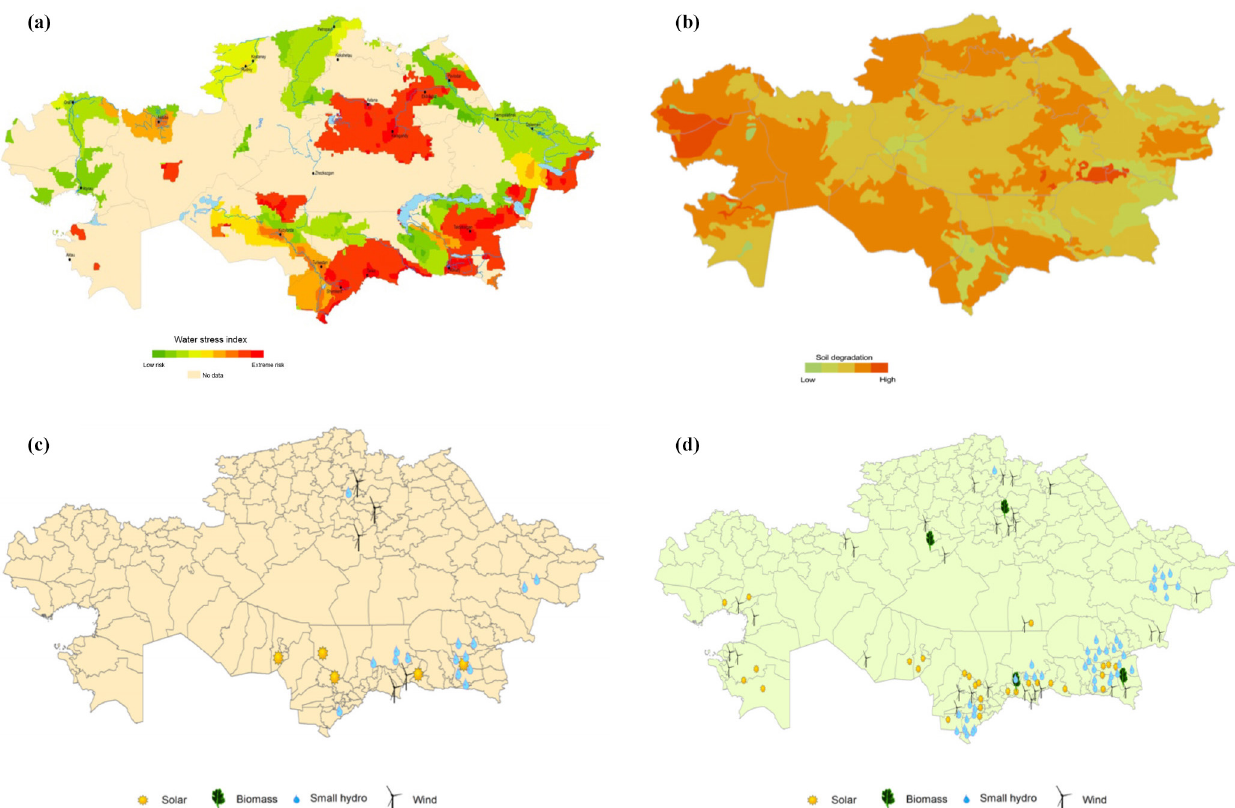
Figure 3. (a) Degree of water stress (WRI, 205); (b) degree of soil degradation (KIG, 2013); (c) current renewable energy projects; (d) future renewable energy projects as a part of Renewable Energy Action Plan for